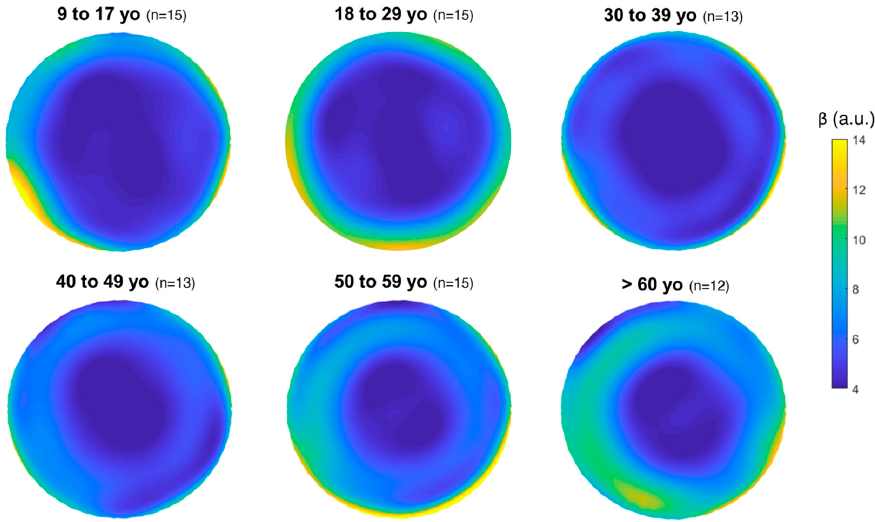
7 of 10 Figure 2. Mean distribution of β (i.e., corneal homogeneity) for each age group in the overall cornea (12 mm diameter). The color bar ( β ) is expressed in arbitrary units (a.u.). The relationship between corneal parameters ( α and β ) and age for di ff erent corneal areas of analysis is displayed in Figure 3. The corresponding results from the Pearson cor- relation coe ffi cient along with their p -value are shown in Table 4.